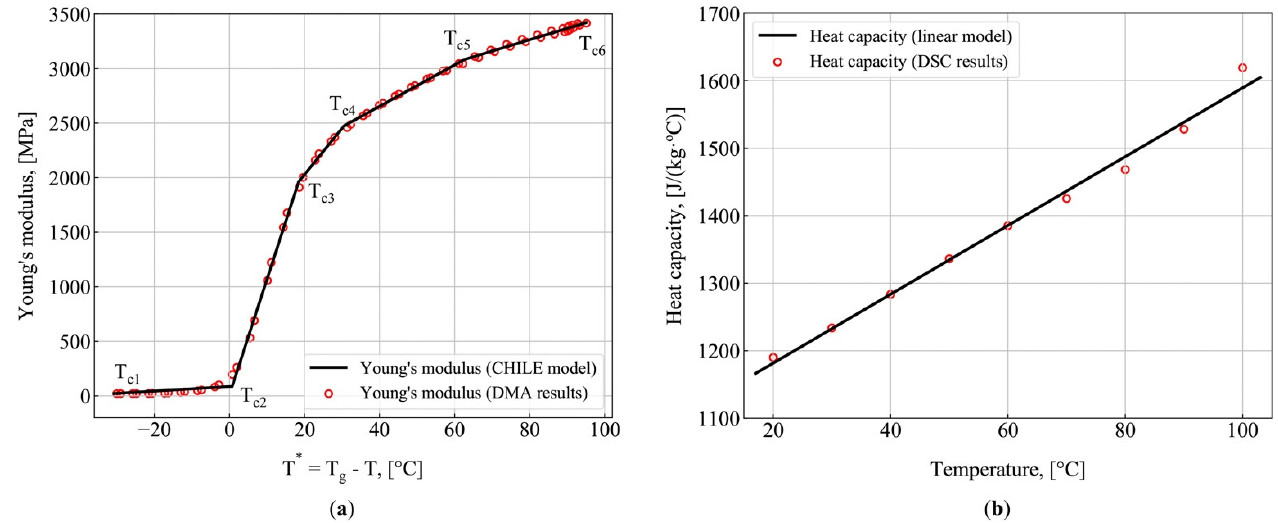
Figure 4. Model parameters measurements: ( a ) Young’s modulus (DMA measurements vs. CHILE model predictions); ( b ) Heat capacity (DSC measurements vs. predictions obtained with the linear